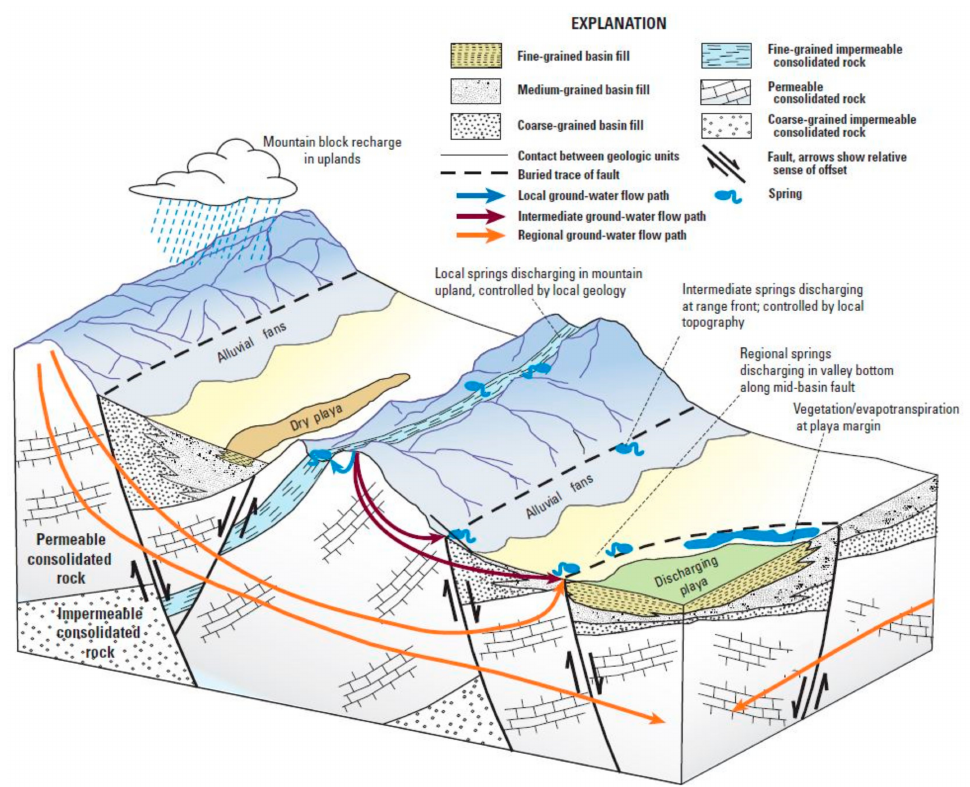
Figure 3. Cross-section of the conceptual model for the hydrology of perennial springs in this region where local and intermediate recharges from precipitation mix with the regional groundwater flow [4].